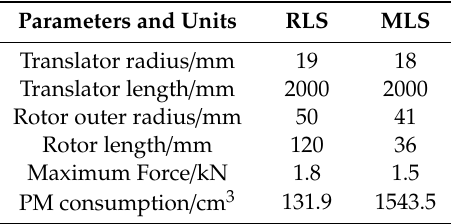
Table 2. Comparisons in the RLS and